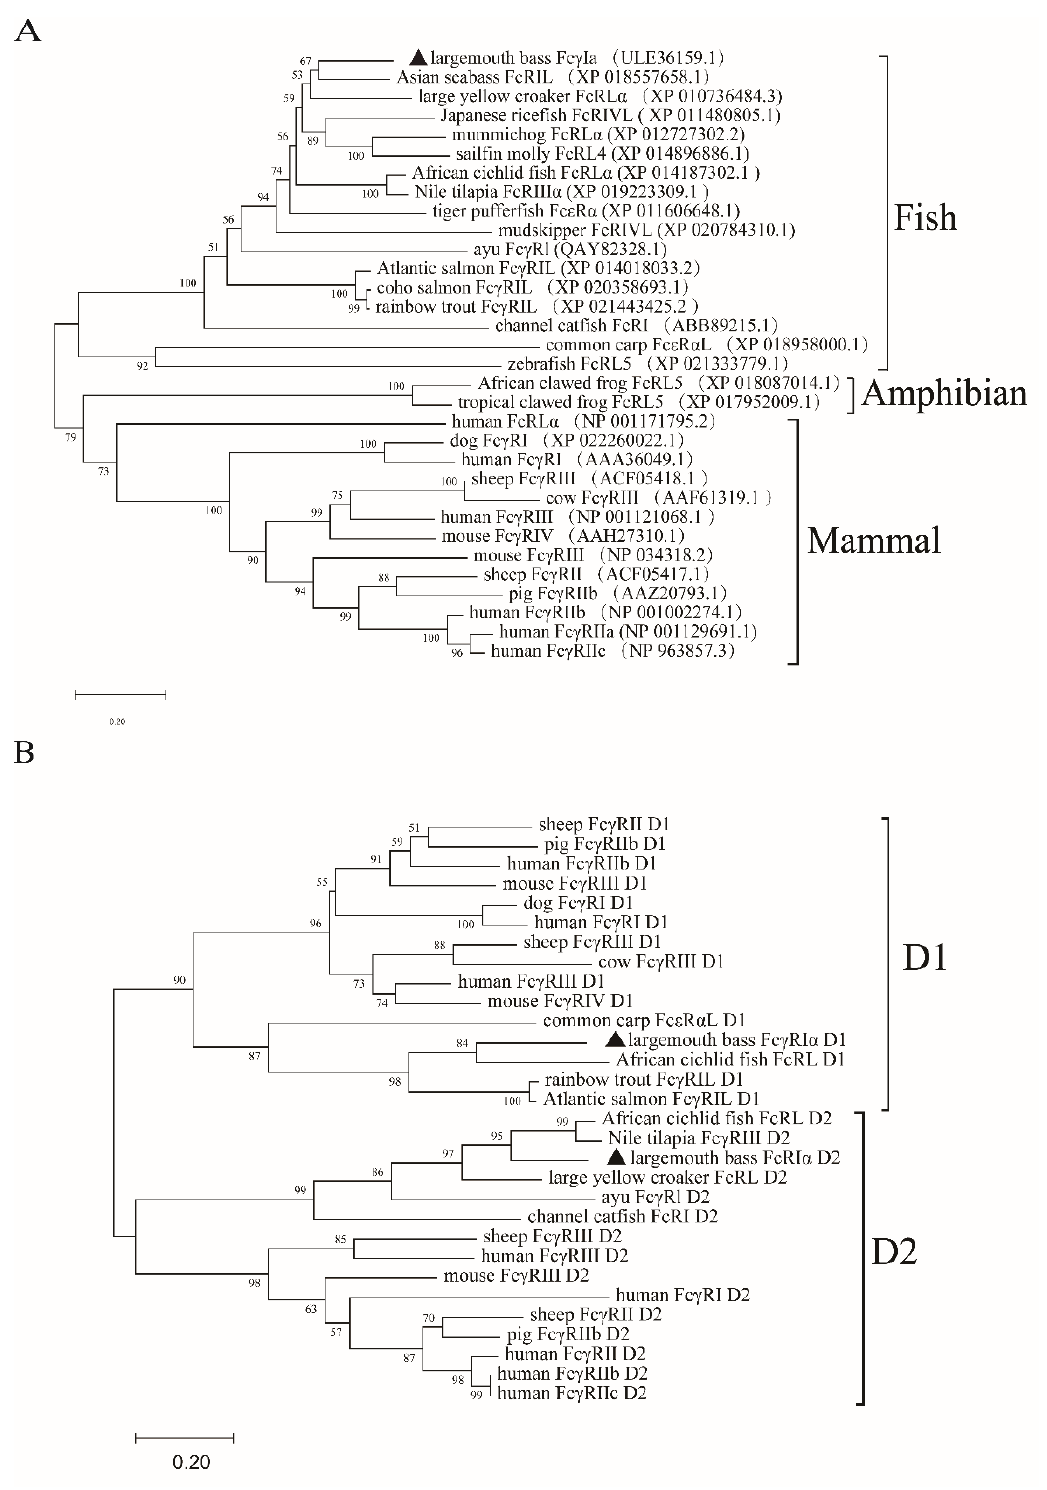
Figure 3. Phylogenetic tree of FcRs of different species. Full-length ( A ) and two Ig domains ( B ) Amino acid sequences of MsFc γ RI α and other vertebrate FcRs were analyzed by the Neighbor-joining method based on the alignment with the Clustal W method. D1 and D2 represent the Ig domain 1 and domain 2, respectively. Numbers at forks show the percentage of branches in which this grouping occurred after bootstrapping on 1000 replicates using the MEGA X program. The scale bar indicates the number of substitutions per